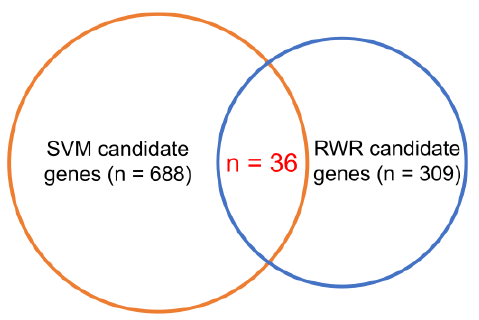
Figure 2. The enrichment map of the gene set enrichment analysis (GSEA) of Gene Ontology (GO) gene sets. The edges between the enriched GO terms indicate that the Jaccard similarity among the gene sets was larger than 0.25, in which the width represents the level of Jaccard similarity. The size of nodes shows the size of GOBP gene sets. The color of nodes indicates the level of adjusted p -values for enriched gene sets.